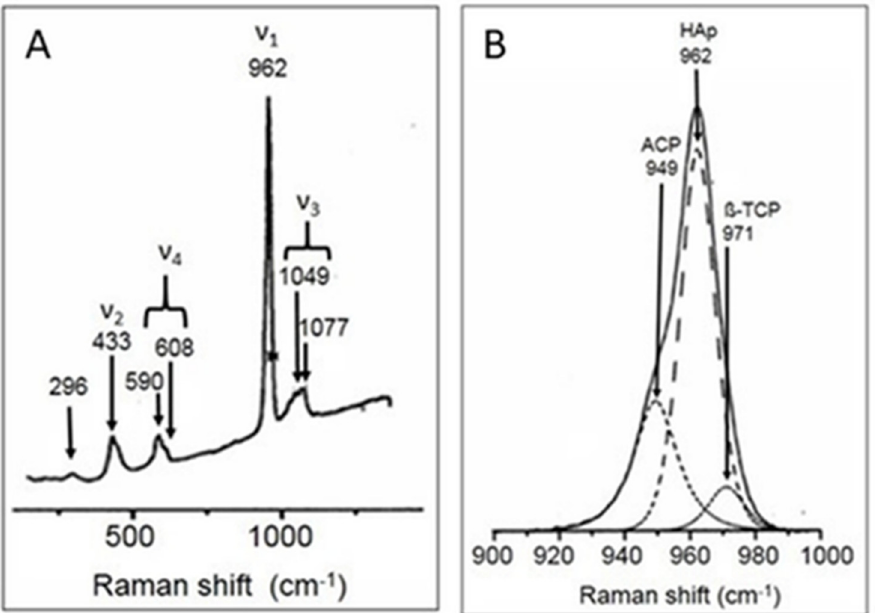
Figure 5. ( A ): Principal Raman vibrational modes of the [PO 4 ] tetrahedron of plasma-sprayed HAp. ( B ): Gaussian–Lorentzian deconvolution of the ν 1 mode (Ar+ laser wavelength λ = 514.6 nm; beam diameter 3 µm; laser power 5 mW) [38,48,49]. Raman microprobe T 64000 (Jobin Yvon), Dept. of